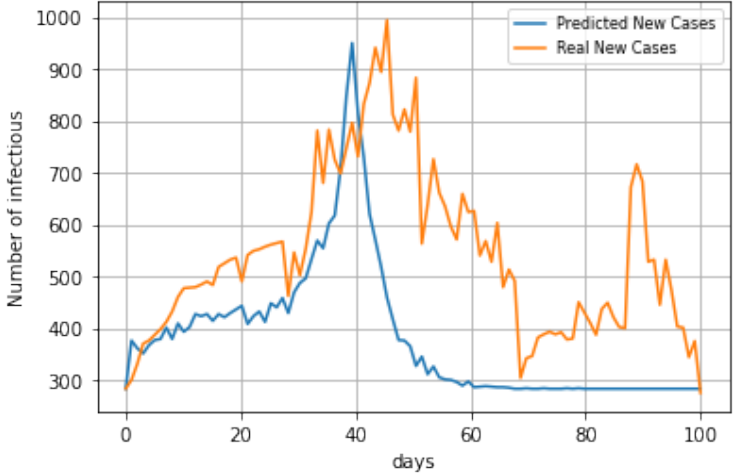
Figure 8. Predicted New Cases vs. Real New Cases Based On Monte Carlo Simulation.